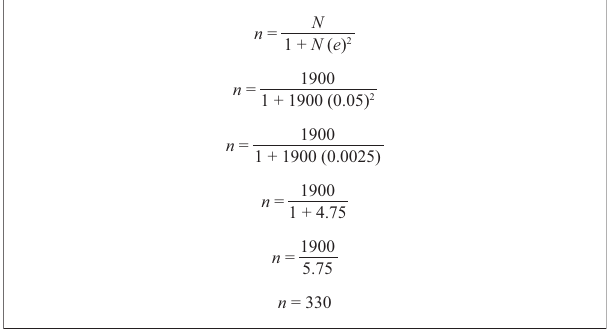
FIGURE 2: Sample